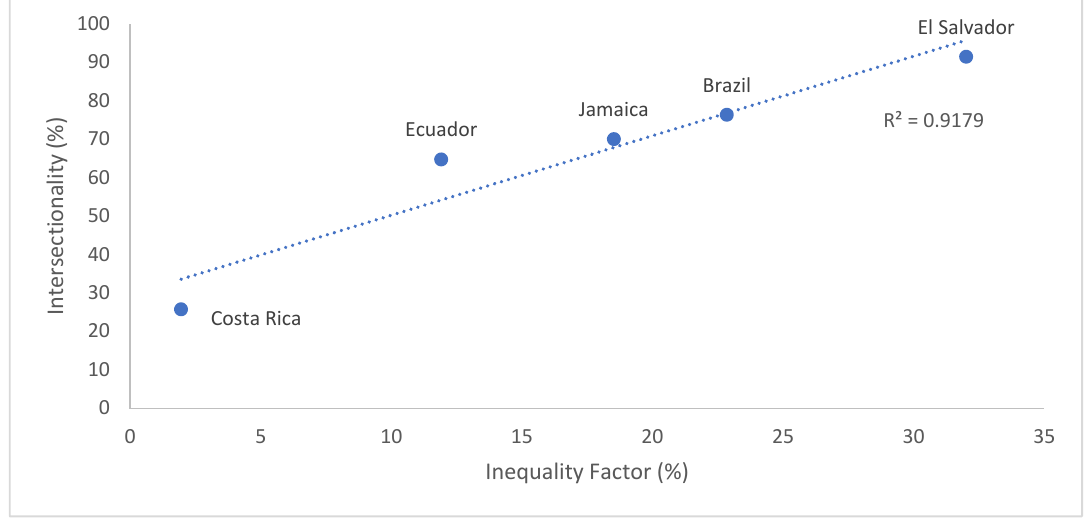
Figure 12. Relationship between analyses of access to sanitation services by intersecting forms of inequality and by inequality factors. Source: Based on census microdata from the IPUMS-International Project [25].